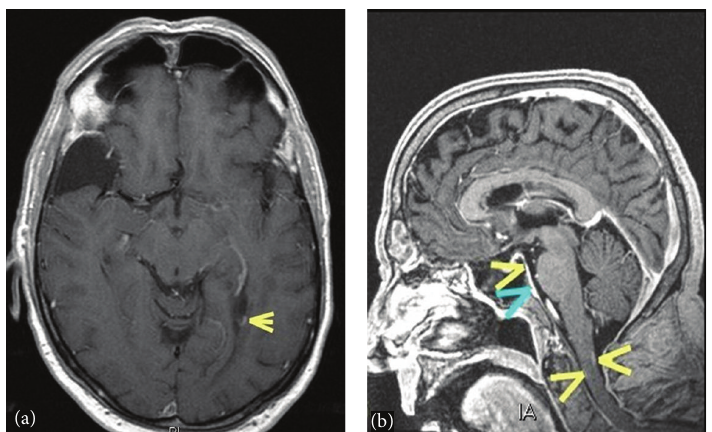
Figure 2: (a) Axial T1 postcontrast image demonstrates an area of ependymal enhancement at the margin of the left lateral ventricle. (b) Sagittal postcontrast T1 volumetric image shows areas of enhancement in the cervical spinal cord (yellow arrows) as well as some areas of pachymeningeal enhancement (blue arrow).